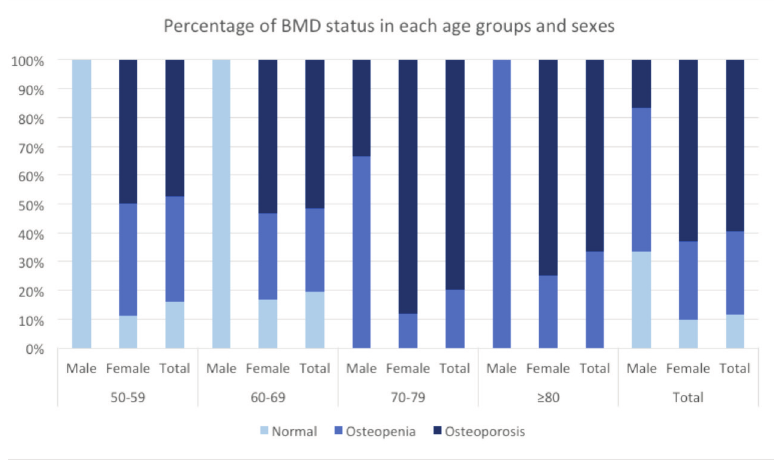
Bone calcification based on bone mineral density as categorised by of age and Fig. 2: